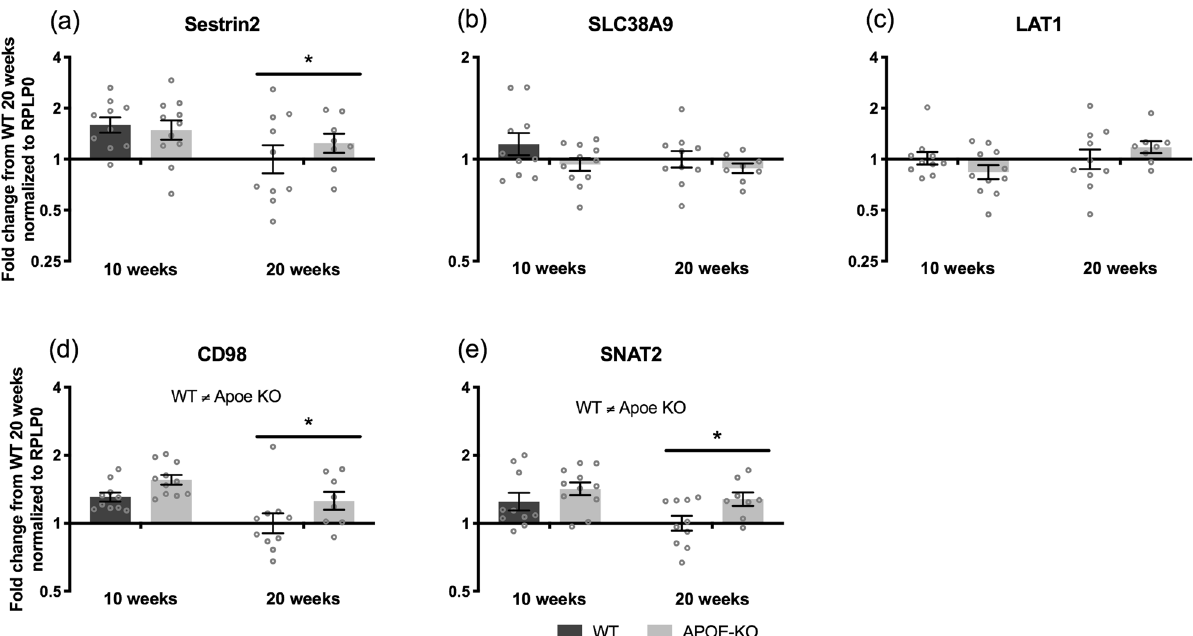
Figure 4. Amino acid transporters and sensors at 10 (WT n = 10, Apoe KO n = 11) and 20 (WT n = 10, Apoe KO n = 8) weeks fasted. mRNA expression in WT (dark bars) and Apoe KO (grey bars) mice of Sestrin 2 ( A ), SLC38A9 ( B ), LAT1 ( C ), CD98 ( D ), and SNAT2 ( E ) at 10 and 20 weeks. Data were normalized to RPLP0 and expressed as fold change from WT 20 weeks and individual values are shown with bars indicating geometric means ± back-transformed SEM. * difference between time points, p <